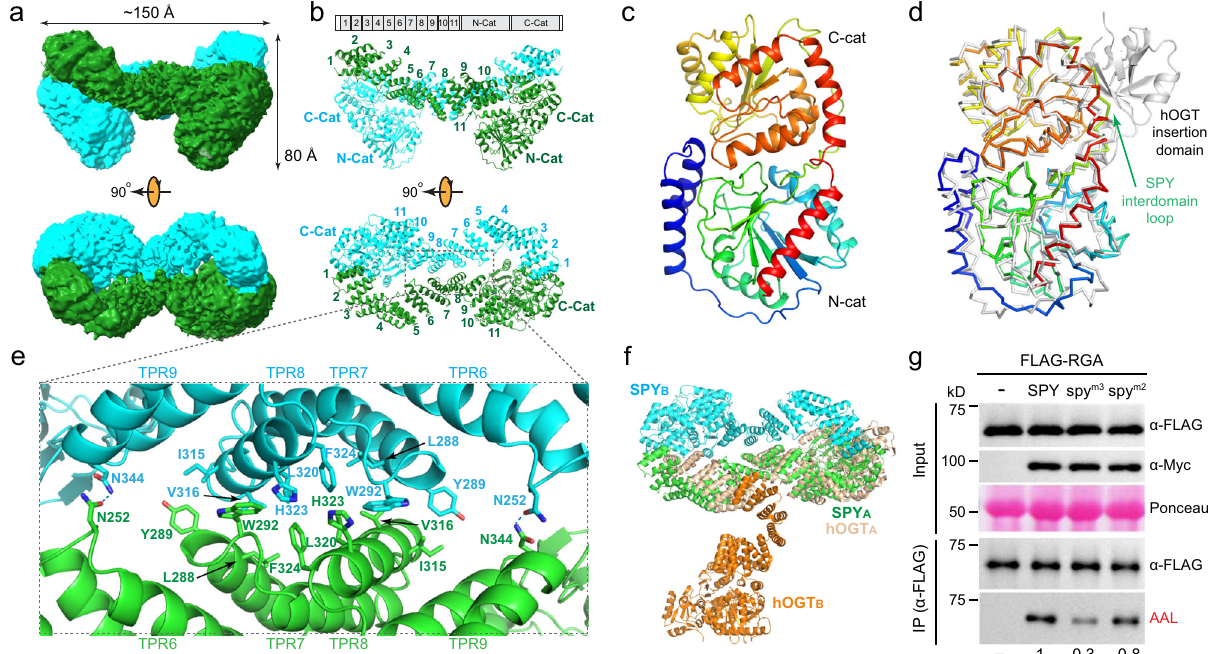
Fig. 1 | Arabidopsis SPY forms an antiparallel dimer. a Cryo-EM density map of SPY from the side and top views, with individual monomers colored in green and cyan. b Ribbon diagram of the SPY dimer, revealing all 11 predicted TPRs, the catalytic domain, and an overall dimer arranged in the shape of fi gure “ 8 ” . The individual TPRs and the N-terminal half (N-Cat) and C-terminal half (C-Cat) of the catalytic domain are labeled. c Catalytic domain of SPY is shown in the cartoon model and colored in rainbow with the N-terminus in blue and C-terminus in red. d Overlay of the SPY catalytic domain (rainbow) with the hOGT catalytic domain (gray; PDB 3PE3). The SPY interdomain loop connecting the N-Cat and C-Cat and the hOGT insertion domain are labeled. e The dimeric interface of SPY formed by antiparallel packing of TPRs 6 – 9. Interfacial residues are shown in the stick model andarelabeled. f SPYandhOGThavedissimilardimericinterfaces.SubunitsofSPY